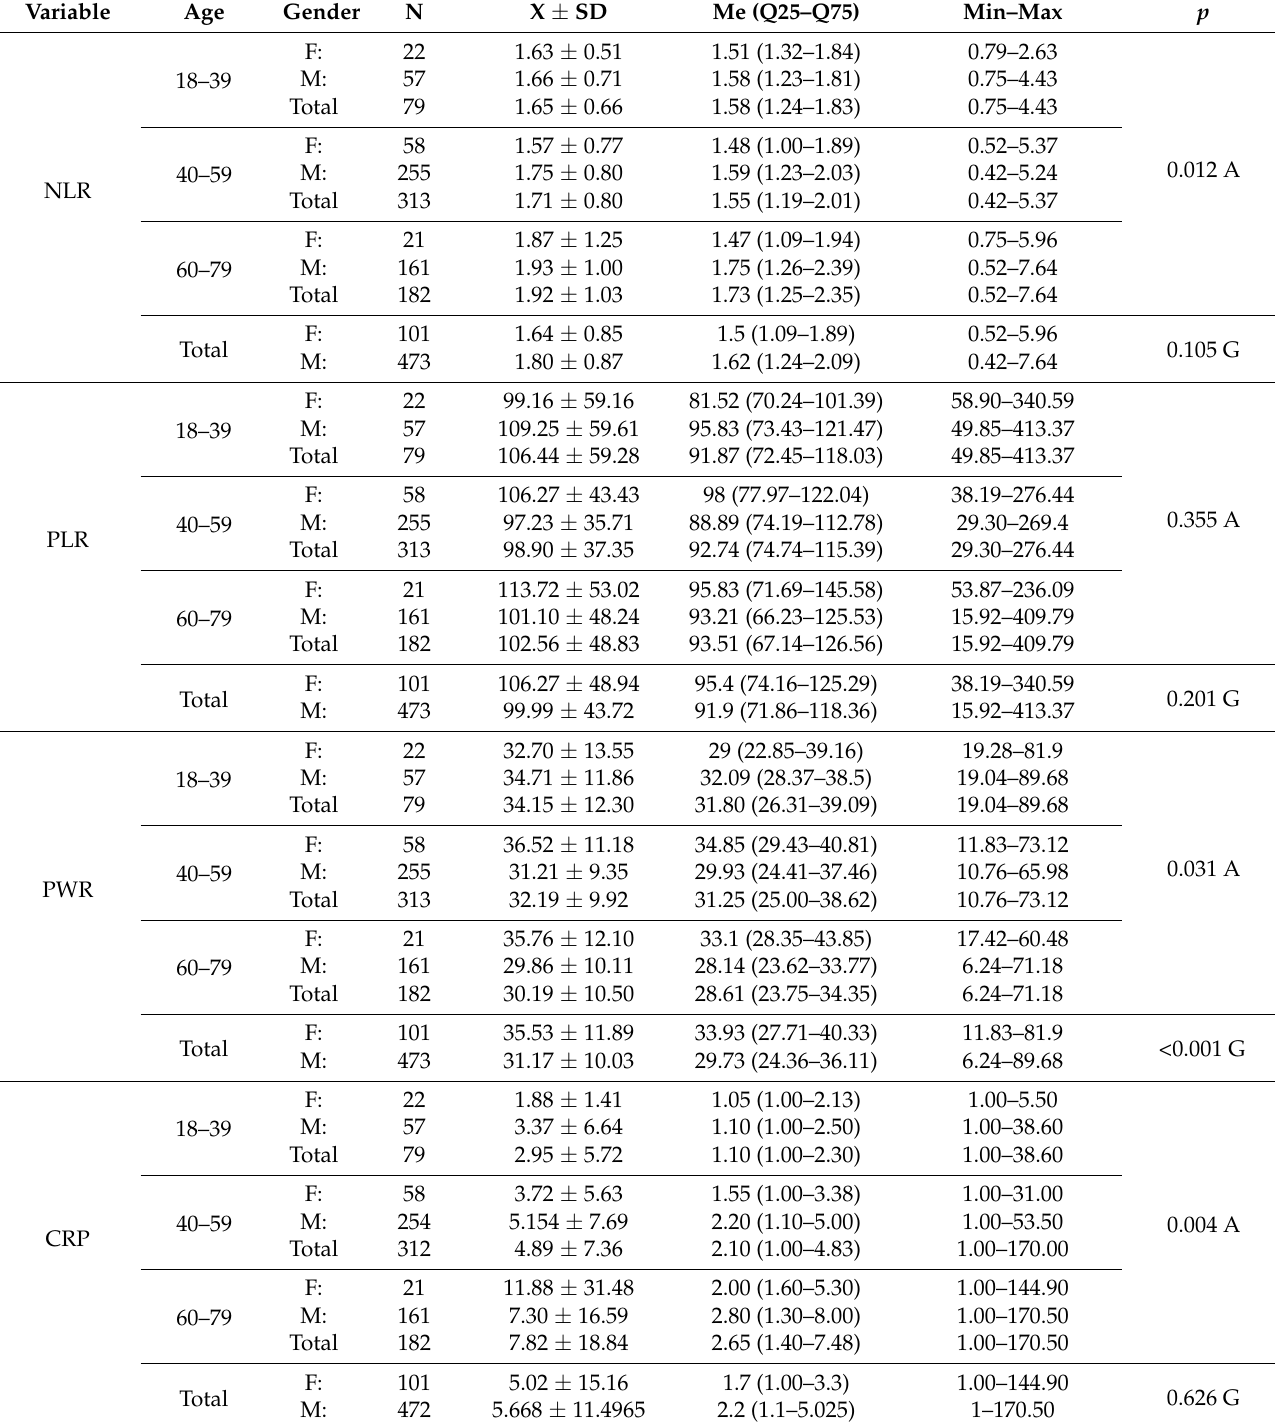
Table 8. Mean values of neutrophils-to-lymphocytes ratio (NLR), platelets-to-lymphocytes ratio (PLR) and platelets- to-leukocytes ratio (PWR) and concentration of C-reactive protein (CRP) in the homeless people according to gender and